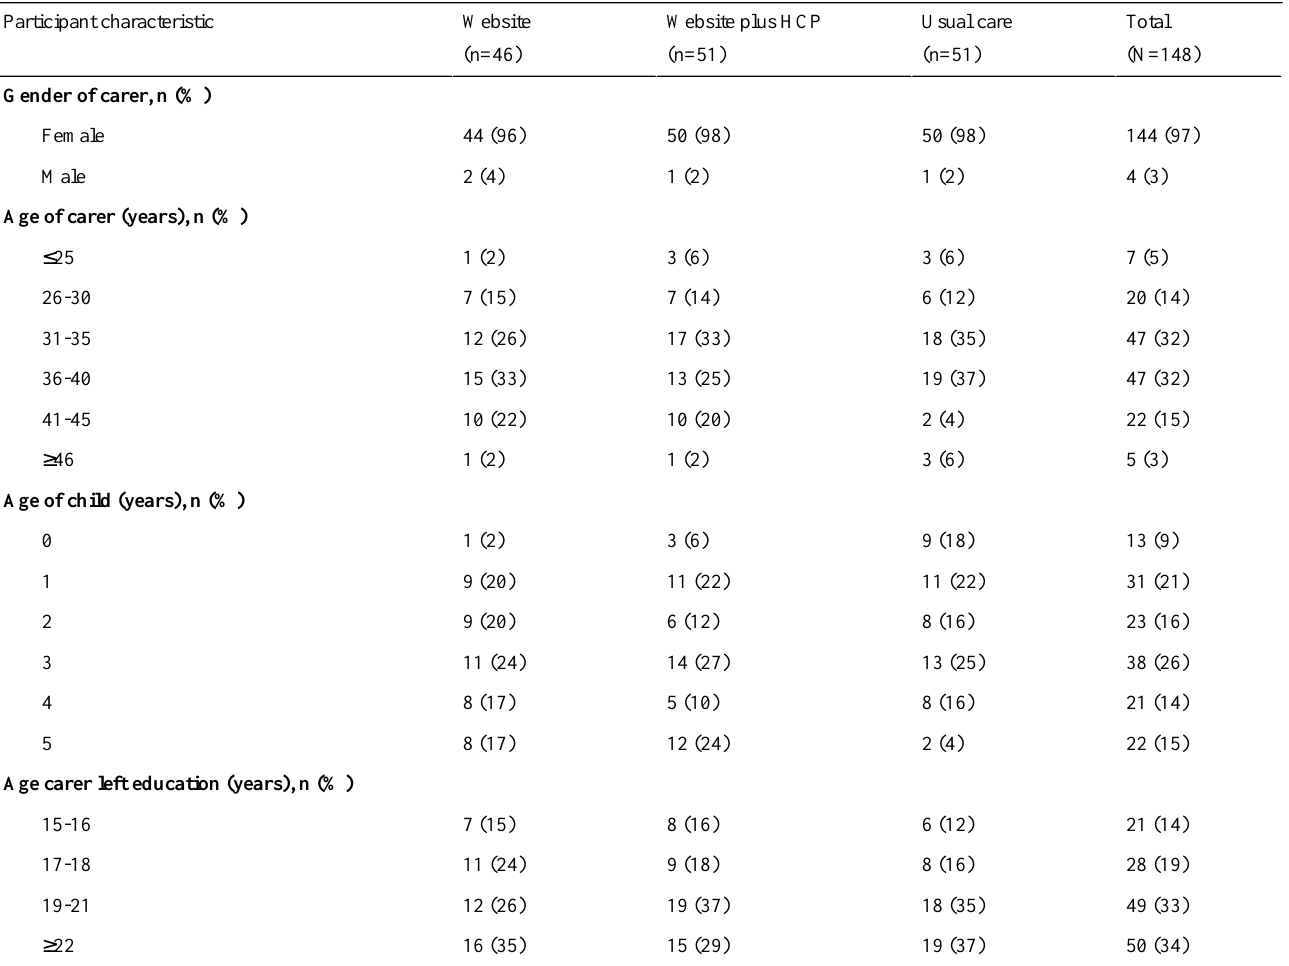
Table 2. Participant characteristics.